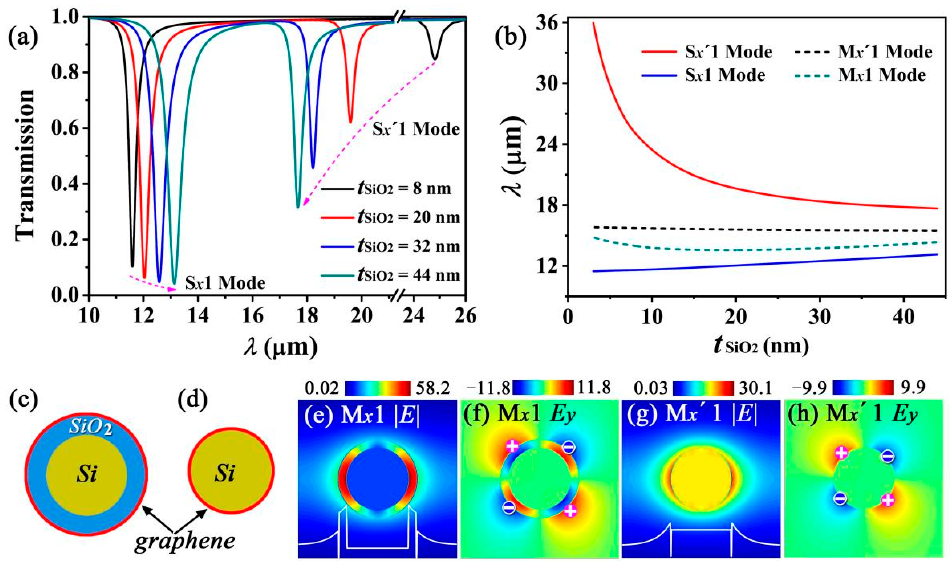
Figure 3. ( a ) Simulated transmission spectra with different t SiO 2 . ( b ) Resonant wavelength as a func- tion of t SiO 2 for different modes. ( c , d ) show the schematics of the components of the graphene hybrid waveguide array (GHWA) and the graphene-coated nanowire array (GCNA) gratings, respectively. ( e , f ) show the | E | and E y distribution of the M x 1 mode on the cross-section of the graphene hybrid waveguide, respectively. ( g , h ) show the | E | and E y distribution of the M x ′ 1 mode on the cross-sec- tion of the graphene-coated nanowire waveguide, respectively. The white lines in ( e , g ) describe the | E | distribution of the M x 1 and M x ′ 1 modes along the x -axis direction of the corresponding wave- guides, respectively. The “+” and “ − ” symbols in ( f , h ) represent the positive and negative charges, respectively.